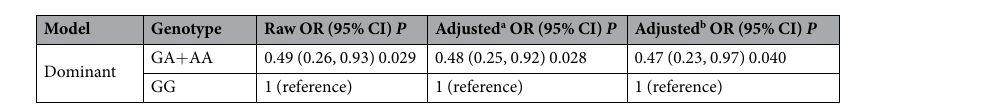
Table 3. Effect of the G-395A polymorphism on frailty modeled with dominant model (A allele). a Adjusted for age, gender, and educational levels. b Adjusted for age, gender, educational levels, weight, height, cognitive impairment, alcohol consumption, smoking, exercise habit, and